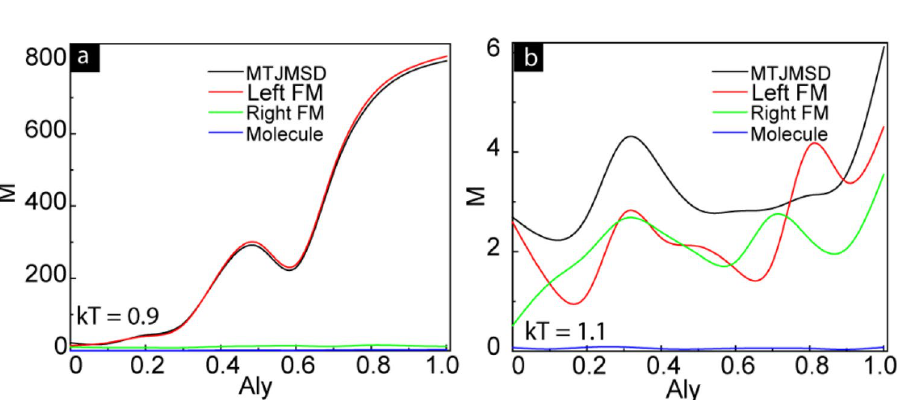
Figure 8. Anisotropy dependence of magnetic moment of MTJMSD, left FM, right-FM, and molecules at ( a ) kT = 0.9 and ( b ) kT =